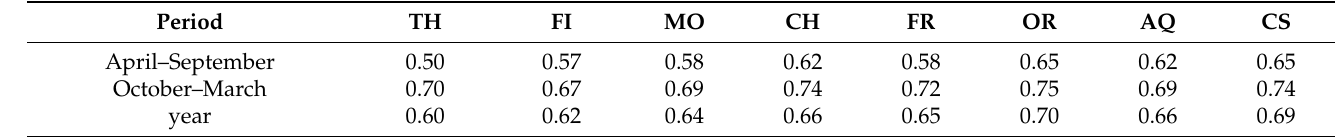
Figure 10. Scatterplot of PM2.5 measured at the traffic stations FI and MO, summer ( left ) and winter ( right ) semester. Table 5. Pearson linear correlation coefficient matrix for PM2.5 (summer semester above the diago- nal, winter semester below), for the six stations of the coastal strip. Table 4. Summary table of the average of daily values of the PM2.5/PM10 ratio in the eight stations of the network in the two-year period 2017–2018 average value in the summer semester, in the winter semester, and for the whole